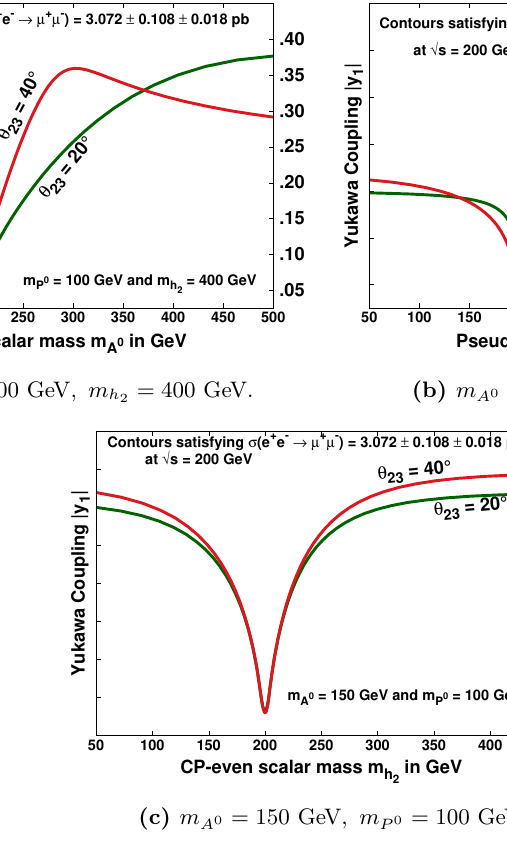
Figure 4. Contours in the plane defined by scalar/ pseudo-scalar mass and its coupling | y 1 | with SM leptons satisfying the combined analysis of DELPHI and L3 σ ( e + e − → µ + µ − ) = √ 3 . 072 ± 0 . 108 ± 0 . 018 pb at s = 200 GeV [63] for three benchmark points corresponding to two choices of the mixing angle θ 23 = 20 ◦ and 40 ◦ respectively. The parameter space lying above the contour are forbidden by LEP